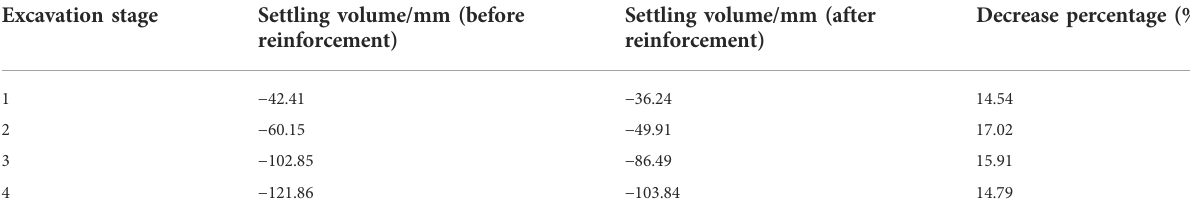
TABLE 4 Comparison of the calculated values of surface settlement between the new method and the old method. Excavation